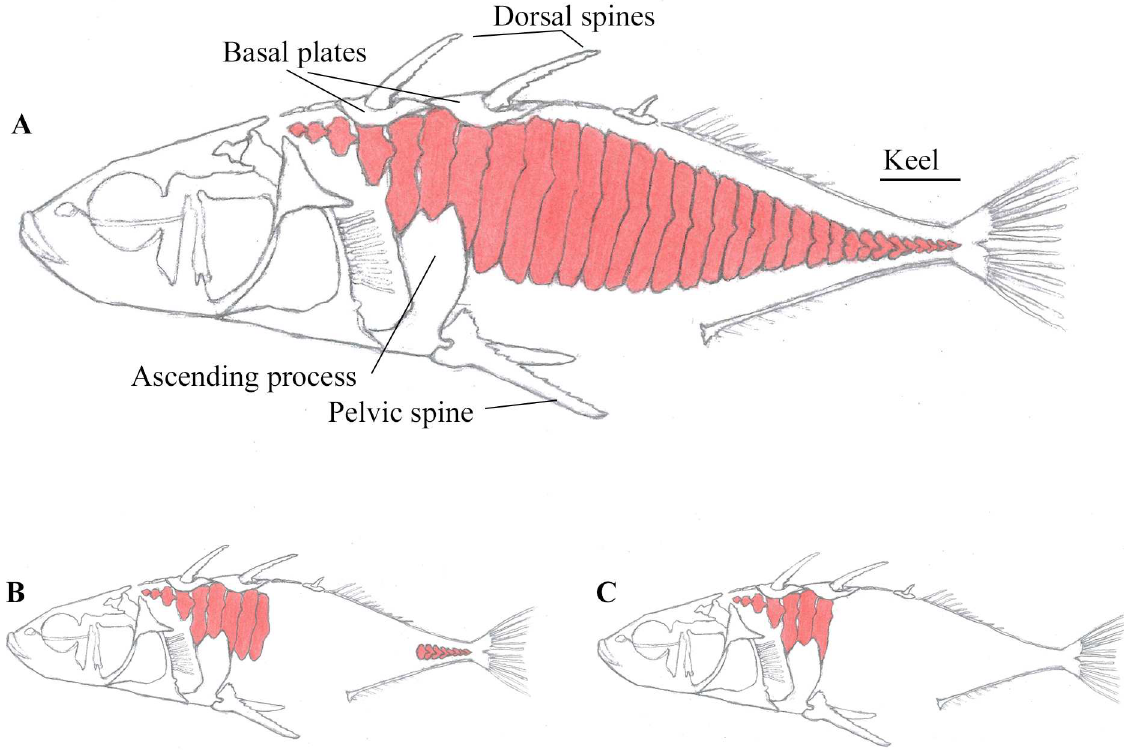
Fig 1. Distribution and variation of lateral plates in threespine stickleback. The complete plate morph (A) with up to 35 lateral plates on each side, covering the anterior region until the caudal peduncle, the partial plate morph (B) lack one or more plates in the midsection or in the keel, and the low plate morph (C) with only plates in the anterior region.